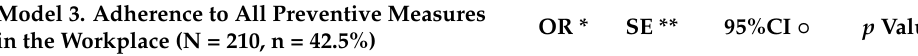
Table 5. Logistic regression model for potential determinants of the outcome of interest (N = 501). Model 3. Adherence to All Preventive Measures in the Workplace (N = 210, n =